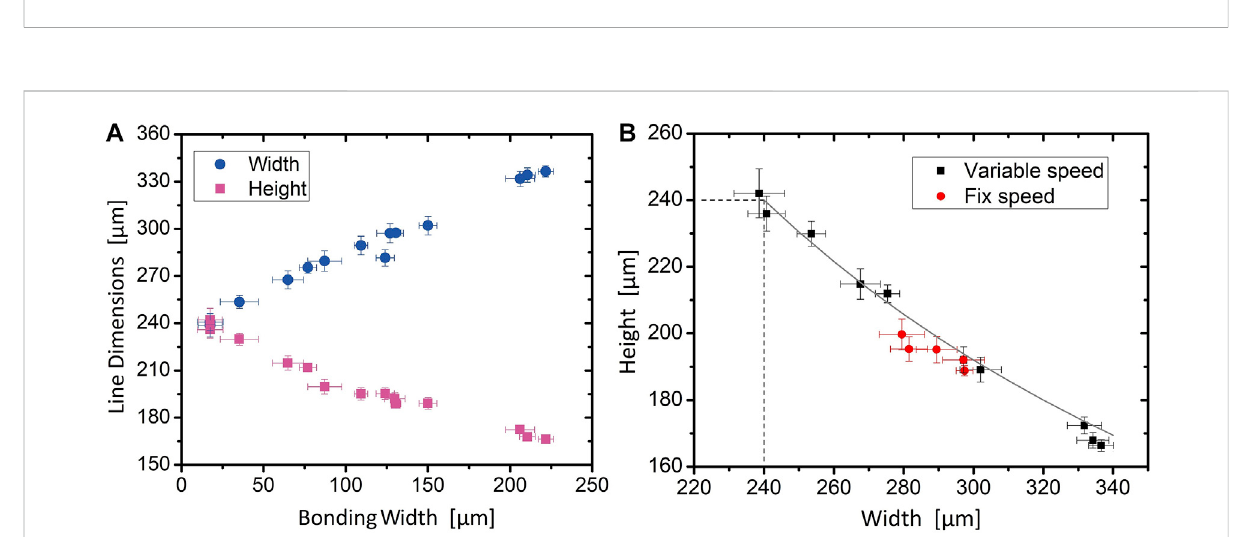
FIGURE 9 Microscopeimage (A) ofthecrosssectionofthemulti-layerprintafterdicing,withthecorrespondinghistogramof (B) themeasuredlayerwidth and (C) the measured bonding